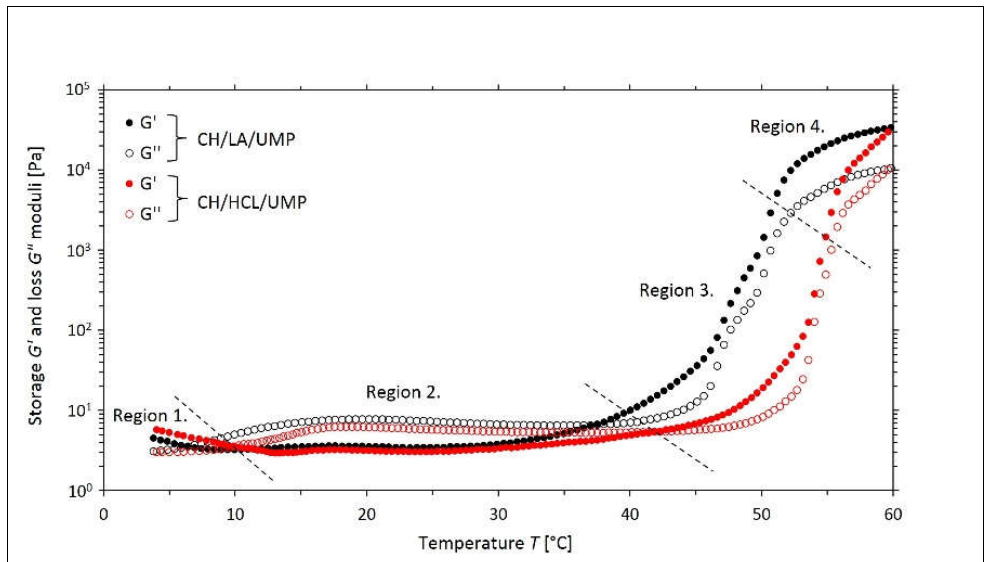
Figure 4. The experimental curves of the changes in the values of the storage G ′ and loss G ′′ moduli as a function of the temperature T obtained for the chitosan lactate solutions (the CH/LA/UMP system) and chitosan chloride (the CH/HCL/UMP system) with uridine 5′-monophosphate disodium salt (UMP).